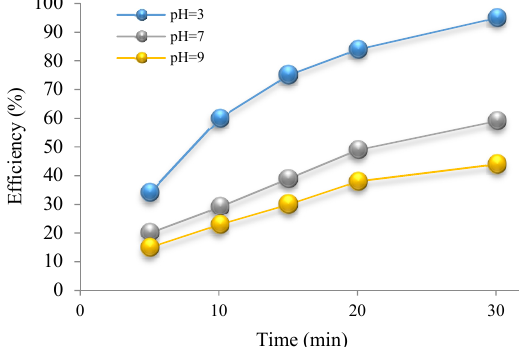
Fig. 5. Effect of initial pH changes on removal of acid blue 113 dye (initial dye concentration: 100 mg/l, modified photocatalyst concentration: 100 mg/l, reaction time: 30 minutes)